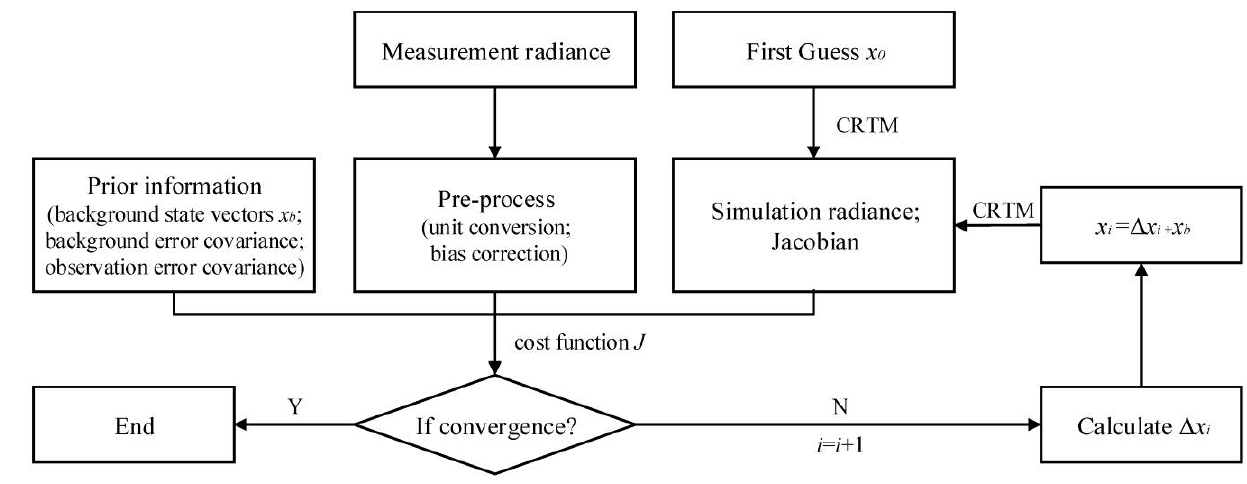
Figure 8. A flow chart of the 1D-VAR